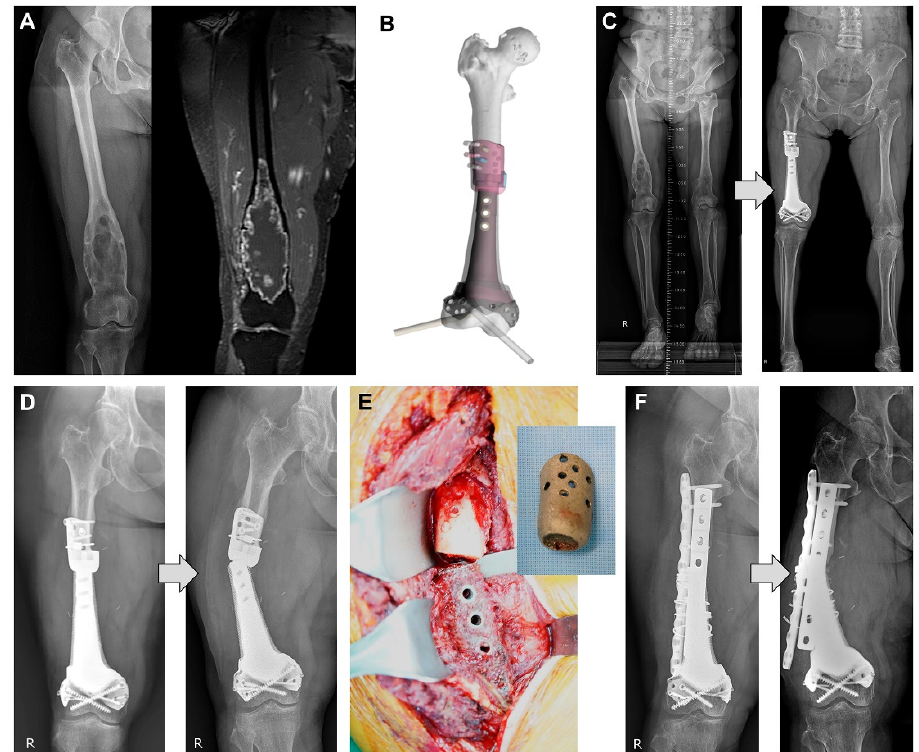
Figure 2. Failure of the 3D-printed implants in the right distal femur. ( A ) A preoperative plain radiography and gadolinium-enhanced T1-weighted magnetic resonance images showing chondrosarcoma in the right distal femur. ( B ) A graphical design of the 3D-printed implant. ( C ) A preoperative ( left ) and postoperative teleradiogram ( right ) after limb salvage surgery. ( D ) Photographs showing implant fracture at 6 months postoperatively. ( E ) Intraoperative photographs and the removed broken proximal part. ( F ) Plain radiographs showing immediate postoperative status after the first revision surgery ( left ) and another mechanical failure 21 months later ( right ).